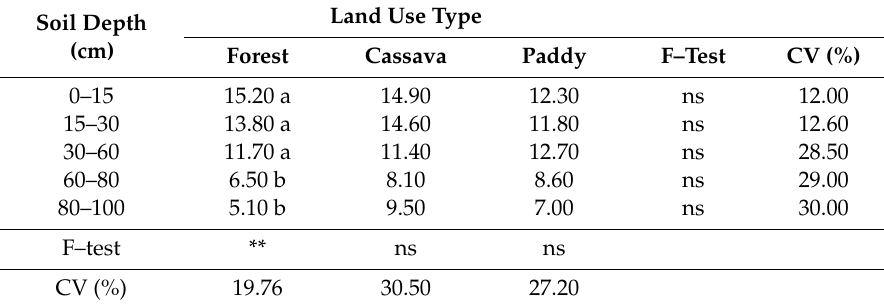
Table 3. Ratio of C:N of soil layers down the soil profile under various land